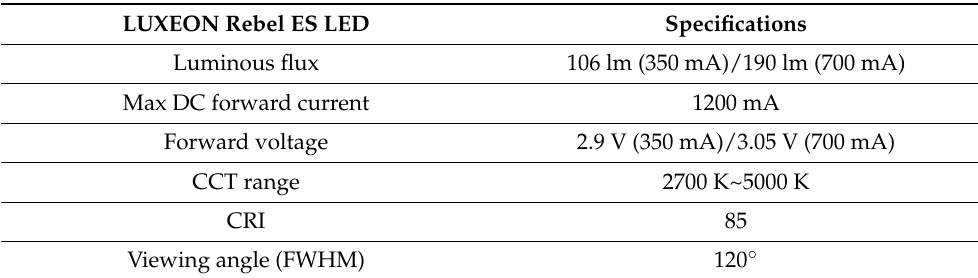
Table 3. Specifications of LUXEON Rebel ES LED